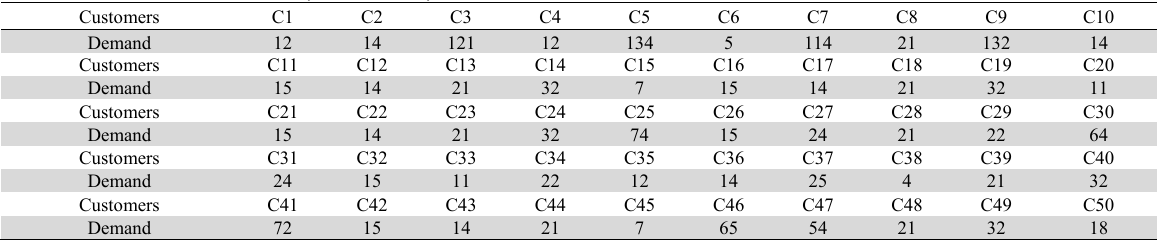
Demand for 50 customers (C1 to C50)